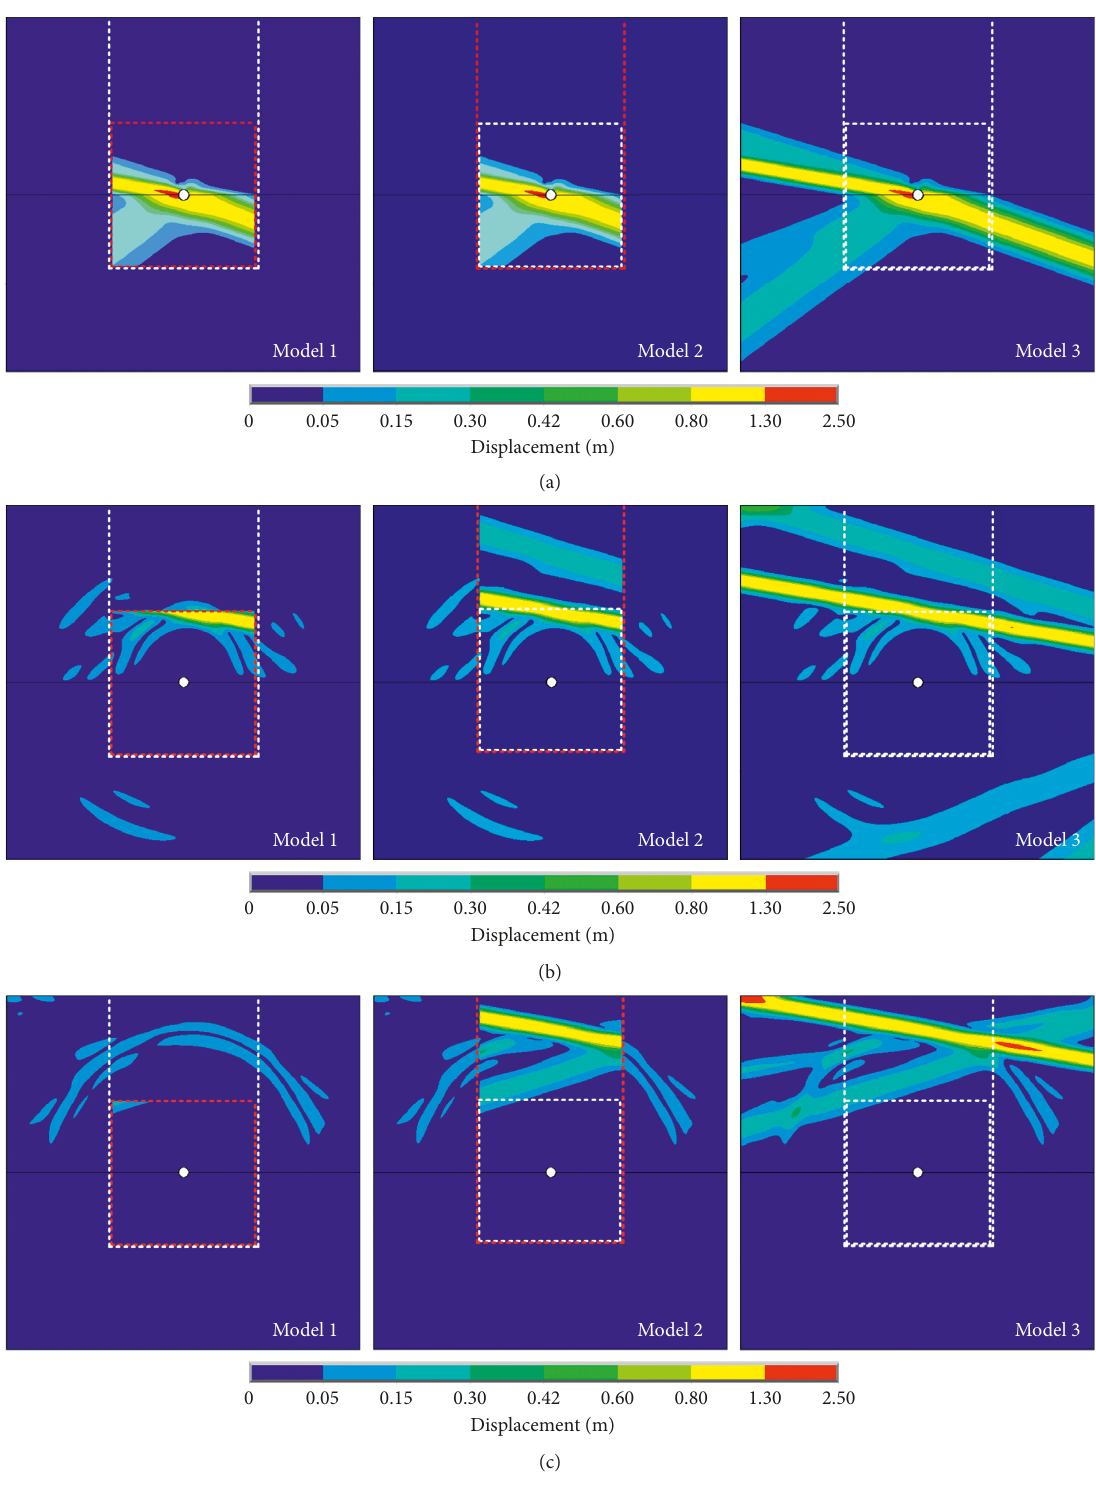
Figure 9: Snapshots of the layered half-space model with an underground cavity: (a) t � 1.15 s, (b) t � 1.55 s, and (c) t � � ] � 0.25, where subscripts 1 and 2 de- Poisson’s ratio ] Figure 10. The dimension of the model is 200 m × 600 m, and 1 2 the cladding is 100 m thick. The diameter of the cavity is note the elastic half space and the cladding. The red dashed 30 m, and its depth is 500 m. The material parameters of the box, which is marked as model 1, denotes the internal � 2500 kg/m 3 , ρ � 2200 kg/m 3 , model are mass density ρ substructure adopted in the modified ISM, which is entirely 1 2 � 800 m/s, c � 500 m/s, and beneath the free surface, and its dimension is 40 m × 40 m. velocity of shear wave c S1 S2